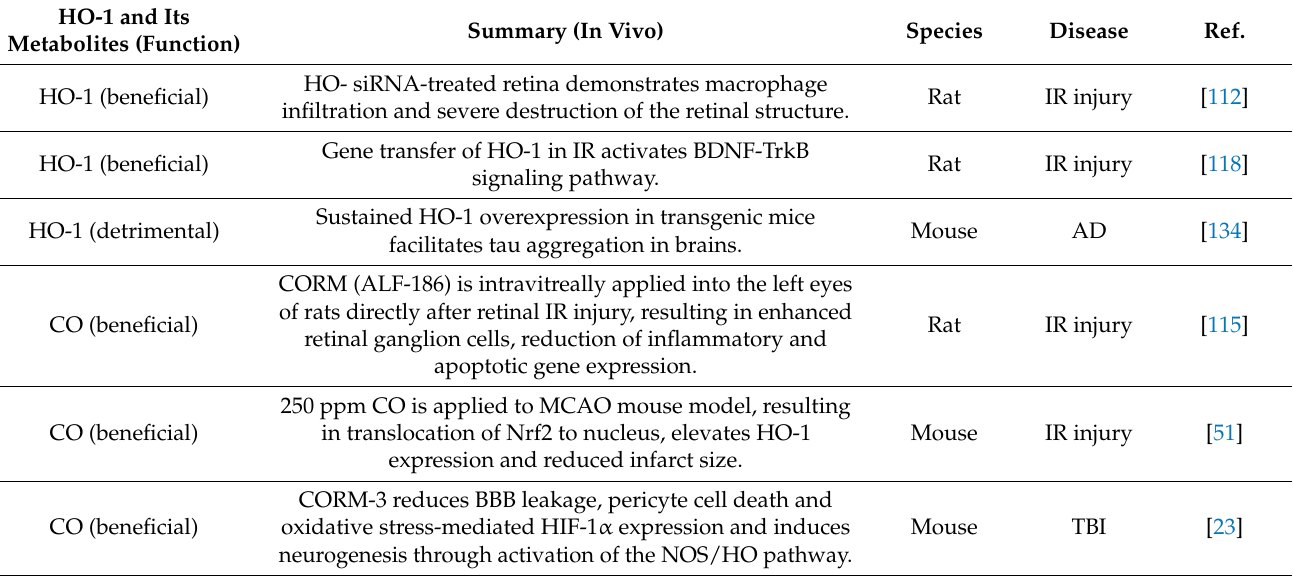
Table 1. Dual in vivo effects of HO-1 and its metabolites in various neurovascular diseases. HO-1 and Its Summary (In Vivo) Species Disease Metabolites (Function)